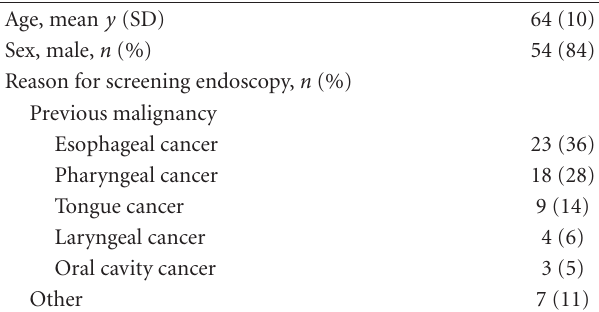
Table 1: The clinical characteristics of the patients ( n = 64).